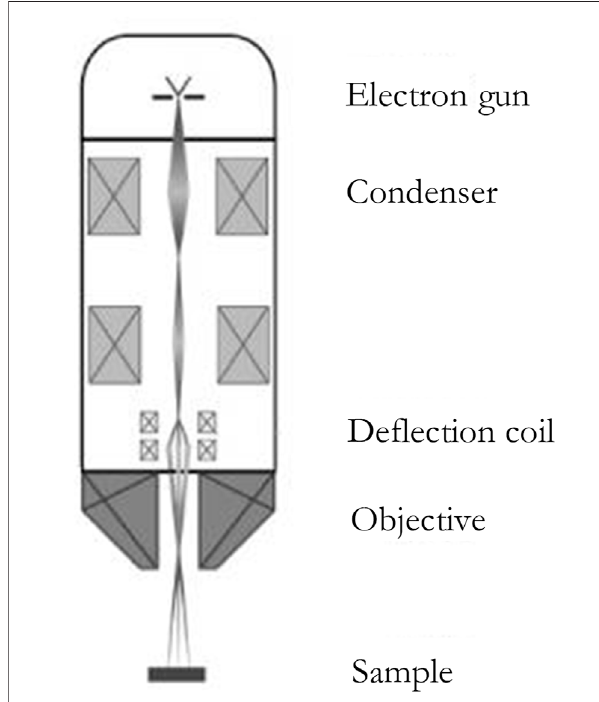
FIGURE 6 | structure of the SEM (Chen et al., 2013).